Question: Condense the content of this figure into a single sentence.
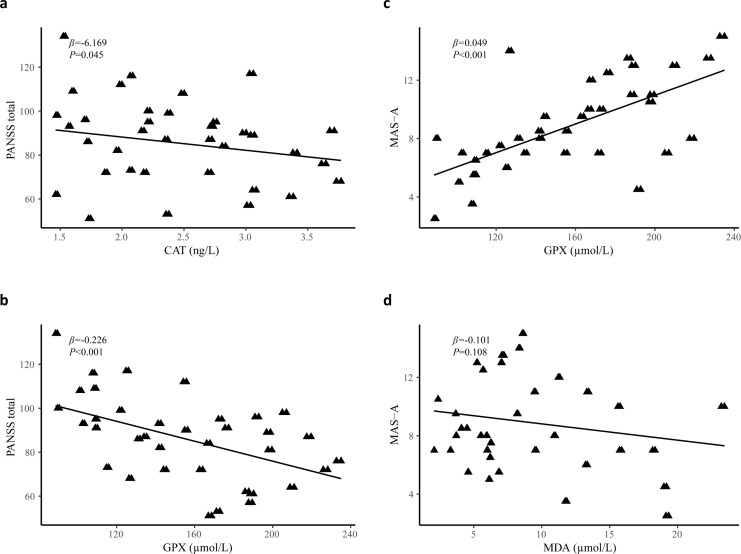
Answer: Correlation between OS markers and the total MAS-A score. MAS-A, The abbreviated metacognitive assessment scale.; SOD, superoxide dismutase; CAT, catalase; MDA, malondialdehyde; GPX, glutathione peroxidase. (a) correlation between SOD and MAS-A total score; (b) correlation between CAT and MAS-A total score; (c) correlation between MDA and MAS-A total score; (d) correlation between GPX and MAS-A total score.